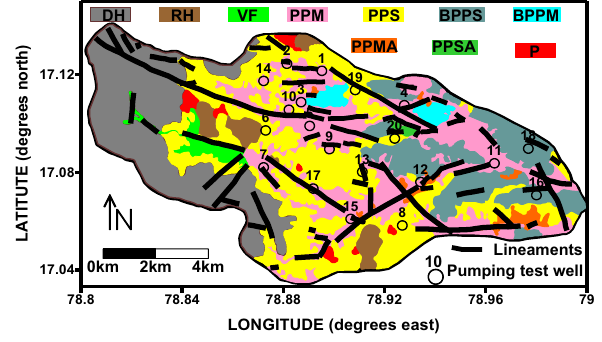
Fig. 2 Geomorphologic map showing pumping test